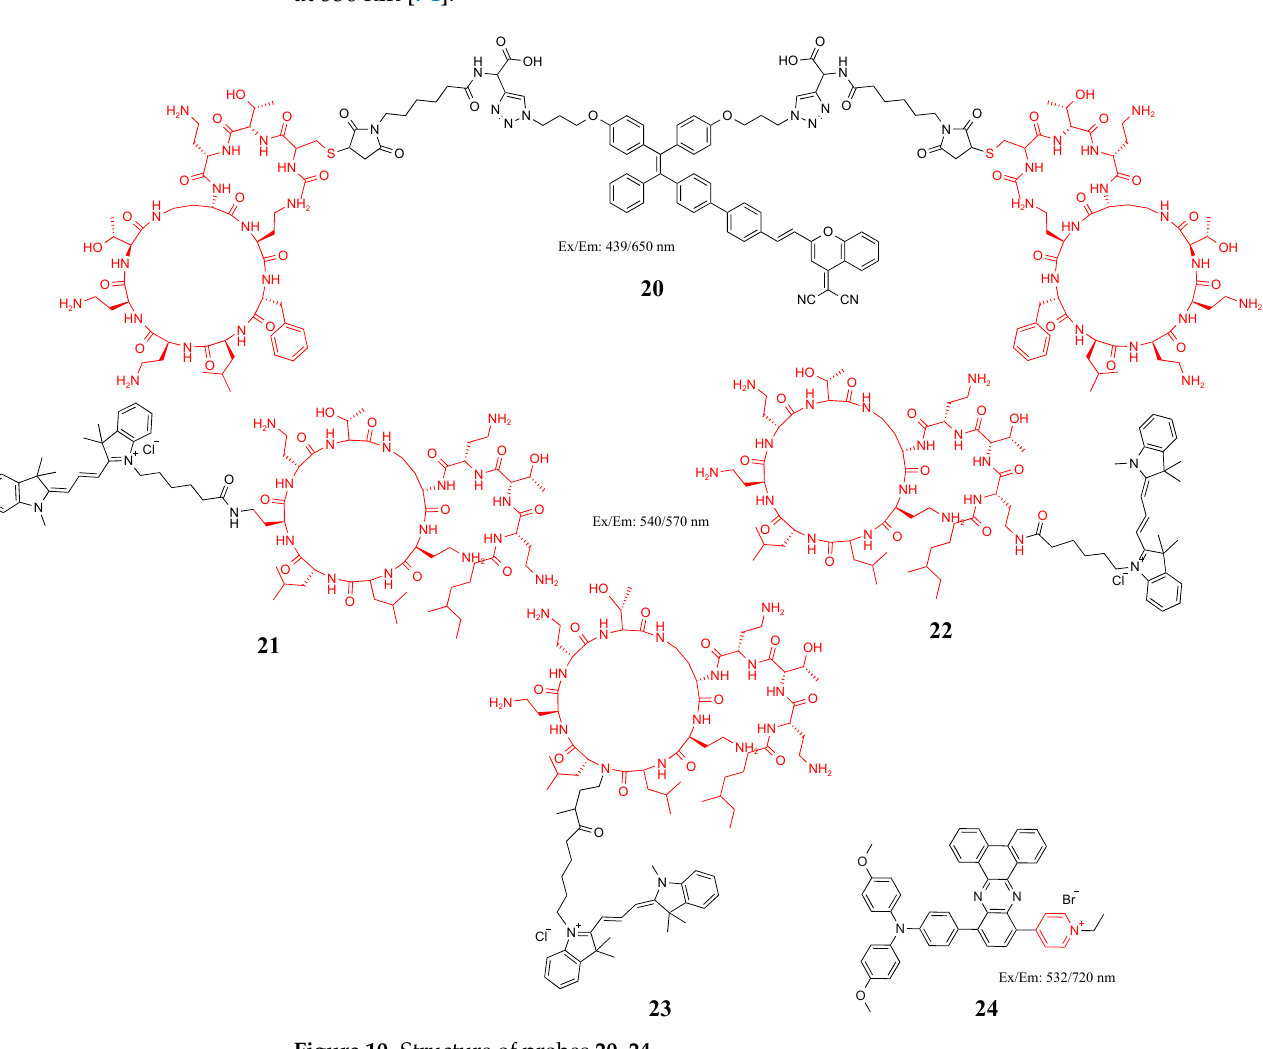
Figure 10. Structure of probes 20 – 24 .